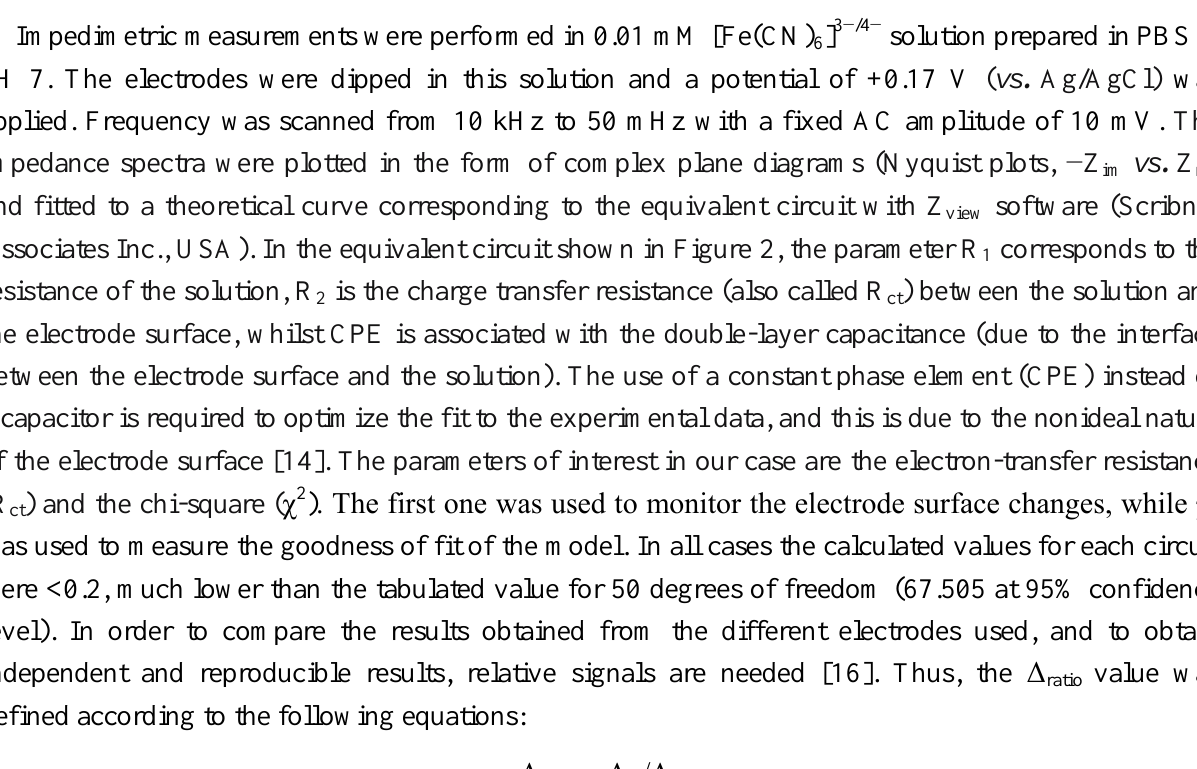
is the resistance of the solution, R 1 2